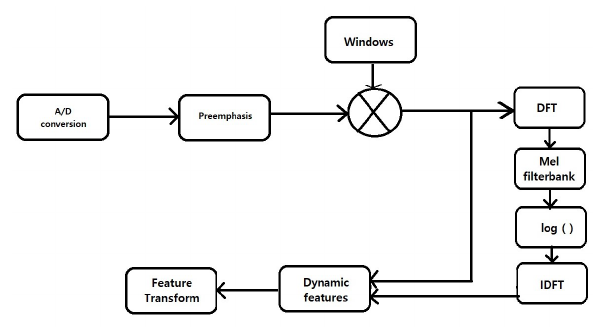
Figure 2: MFCC values in an array